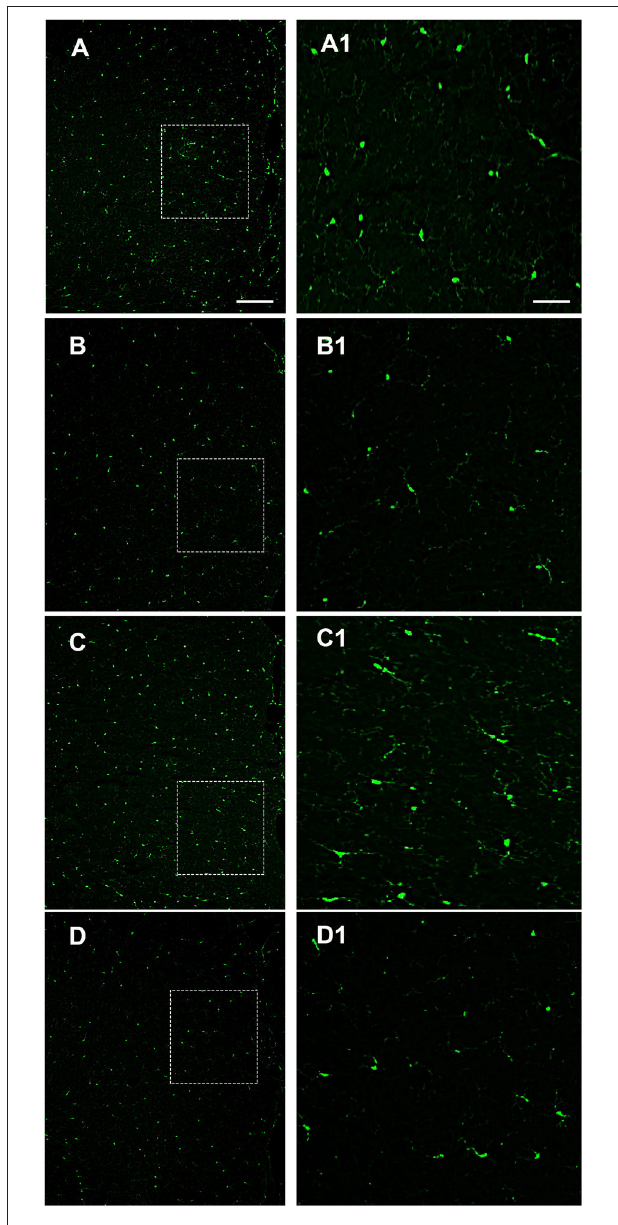
FIGURE 4 | Intraperitoneal administration of OX-A prevents LPS-induced microglia activation in the prefrontal cortex (PFC). Iba-1 immunoreactivity in mice treated with: vehicle (saline) (A) ; LPS (6h; 3.3 mg/kg) (B) ; OX-A (1h; 40 µ g/kg) + LPS (6h; 3.3 mg/kg) (C) ; SB334867 (30min; 30 mg/kg) + OX-A (1h; 40 µ g/kg) + LPS (6h; 3.3 mg/kg) (D) . High magnification of the PFC layers II–III are shown in the boxed area (A1–D1) images. Scale bar: 300 µ m (A–D) , 50 µ m (A1–D1)